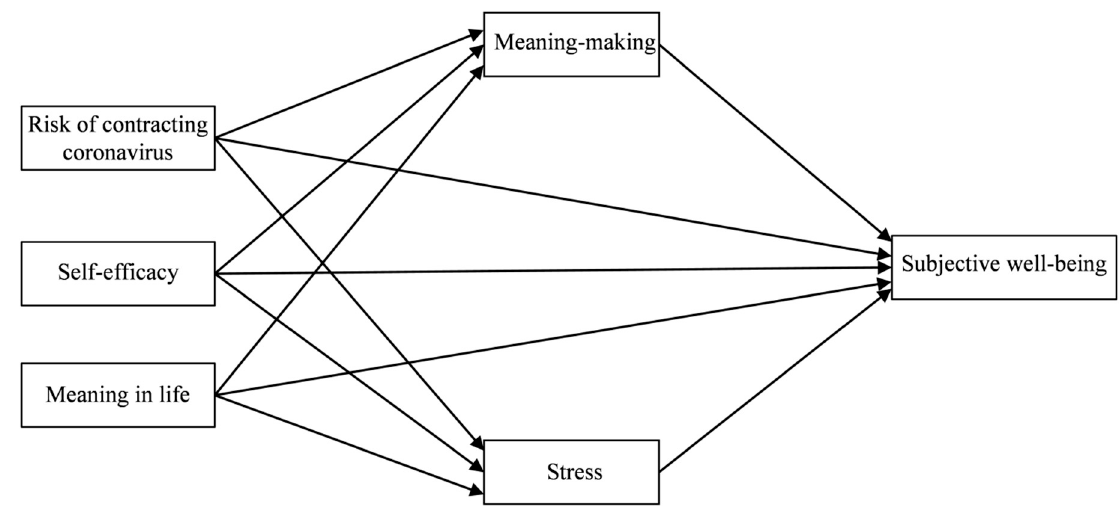
Figure 1. Theoretical model of the relations between risk of contracting COVID-19, self-efficacy, meaning in life, meaning- making, stress and subjective well-being.